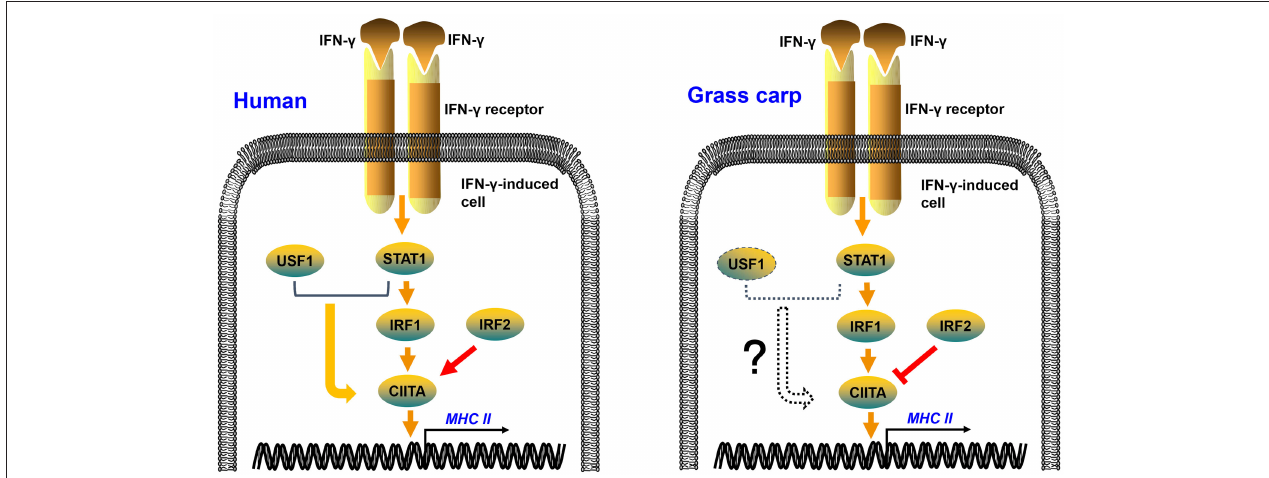
FIGURE 7 | Regulation mechanisms of IFN- γ -induced MHC II expression in human and grass carp. After stimulation with IFN- γ , STAT1, IRF1, CIITA, and MHC II can be induced in human and grass carp. IRF2 and IRF1 cooperatively induce the activation of CIITA in human, while IRF2 binds to the promoter of CIITA and suppresses the expression of CIITA in grass carp. STAT1 and USF1 can cooperatively activate the expression of CIITA in human, but this mechanism may not exist in grass carp because of the absence of STAT1 and USF1 binding sites in the CIITA